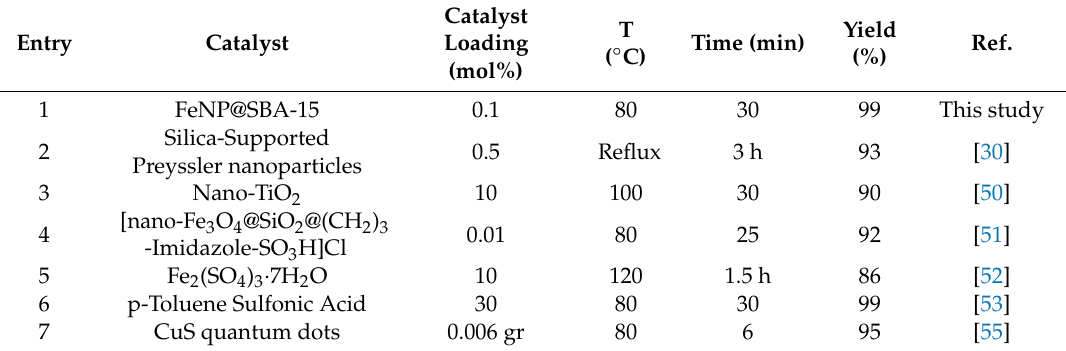
Table 3. Comparative performance of FeNP@SBA-15 with literature reported catalytic systems.